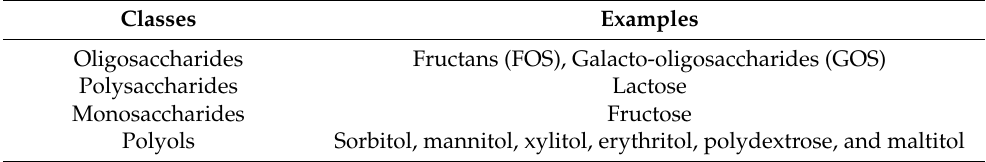
Table 1. Classification of the fermentable oligo-, di-, mono-saccharides, and polyols